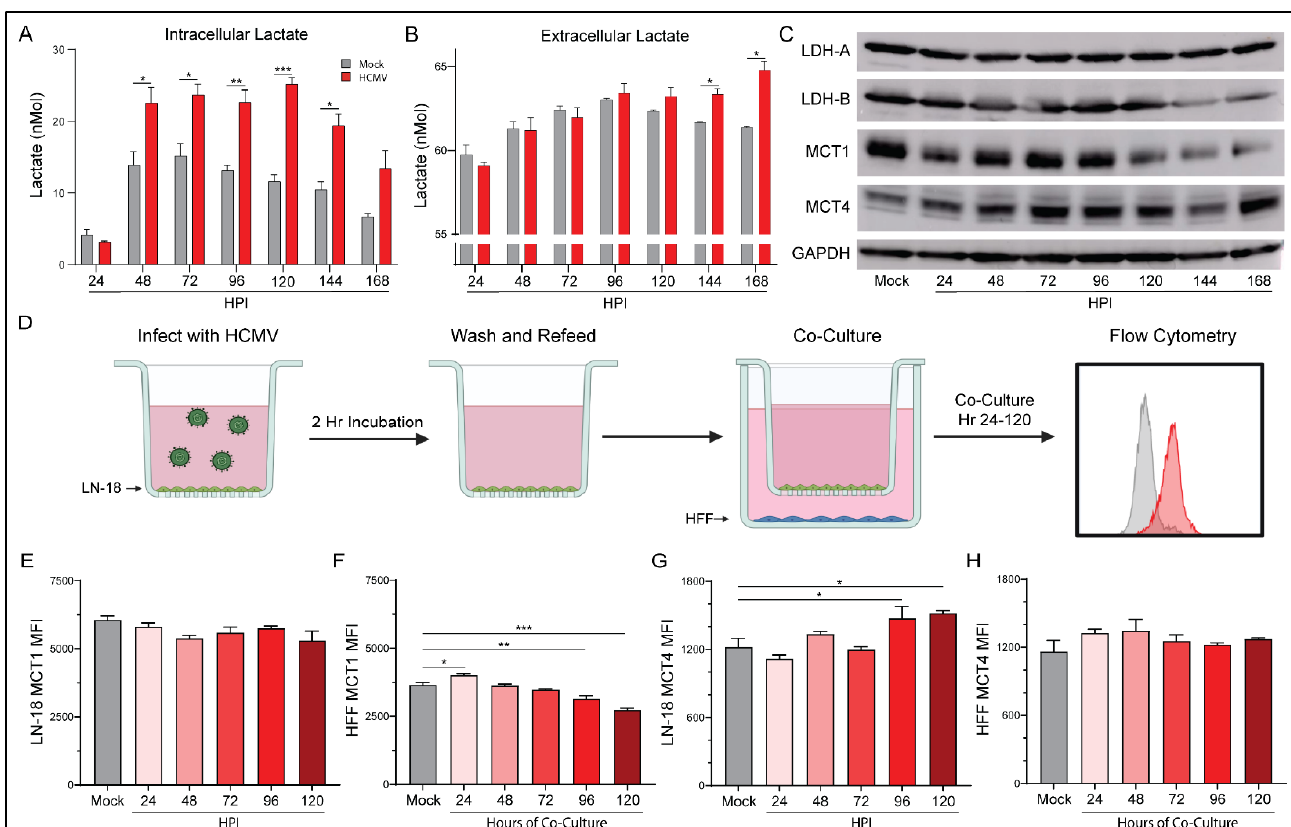
Figure 6. HCMV-associated alterations to lactate dynamics. Lactate concentration was determined in the ( A ) extracellular and the ( B ) intracellular compartment of mock- or HCMV-infected LN-18 cells using a colorimetric L-lactate assay kit with a standard. ( C ) Protein expression of prominent lactate regulators LDH-A, LDH-B, MCT1, and MCT4 were examined following infection using Western blot assays. ( D ) Schematic of co-culture experiment in which HCMV-infected LN-18 cells were co-cultured, but physically separated from, HFF cells using Transwells with 0.4 µ m pores in 6-well culture dishes. At indicated points post infection, cells were collected separately and processed by flow cytometry for expression of MCT1 ( E , F ) and MCT4 ( G , H ) in infected LN-18 and non-infected HFF cells respectively. Graphs represent pooled data from three independent experiments. Mean ± the SEM of at least 3 triplicates. *, p < 0.05; **, p < 0.01; ***, p < 0.001. Created with BioRender.com. Co-culture of HCMV-infected LN-18 with HFFs alters the expression of key metabolic proteins and epigenetic markers in both cell lines. In an effort to examine the effects of HCMV-infected LN-18 cells on neighboring non-cancerous cells, we established physically separated co-cultures with HFFs using 0.4 µ m pore Transwells (Figure 6D). LN-18s were seeded in Transwells and infected with HCMV for two hours followed by washing and refeeding. At this point the LN-18 Transwells were placed in a 6-well plate containing confluent HFFs. This allowed for paracrine communication between cell lines while keeping them physically separated. Flow cytometry demonstrated HCMV-GFP positivity in the LN-18s and an absence of HCMV-GFP positivity at the longest co-cultured timepoint, 120 HPI, in HFFs (Figure 7A). Additionally, HFFs were confirmed negative for CPE and their supernatant was titered and found free of the virus at the longest co-culture timepoint, 120 HPI (Figure